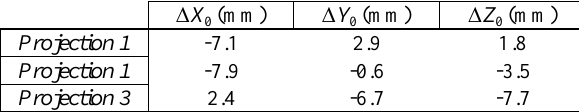
Table 2. Differences between theodolite and image-based exterior orientation